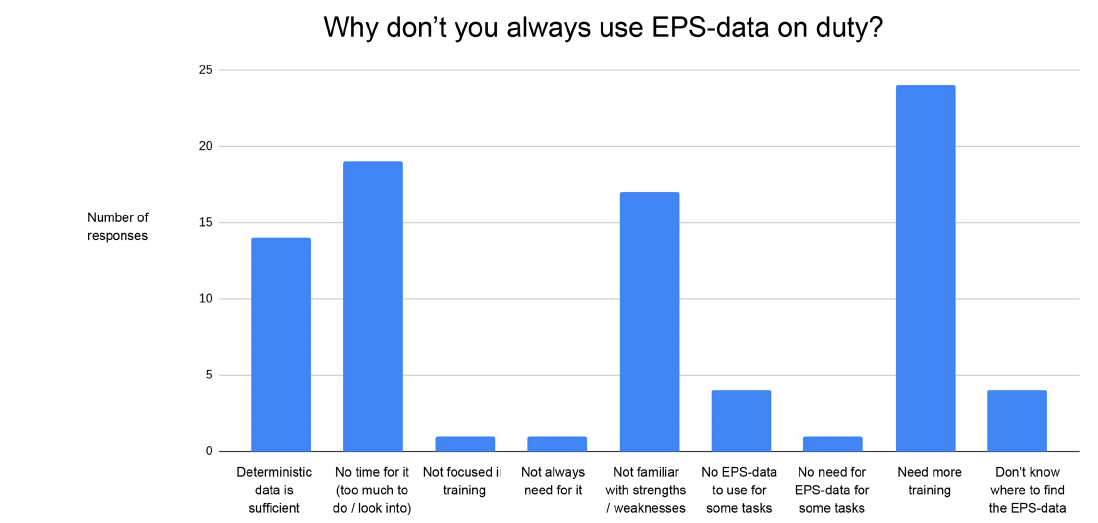
Figure 3. 61 operational forecasters at MET Norway answered this question in the survey (multiple answers were allowed). A need for more training and to learn about strengths and weaknesses with EPS-data/products are perceived as important by many.